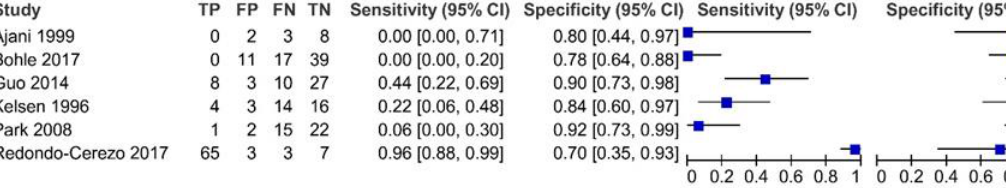
Figure 10. Forest plot for T1 + T2 restaging.